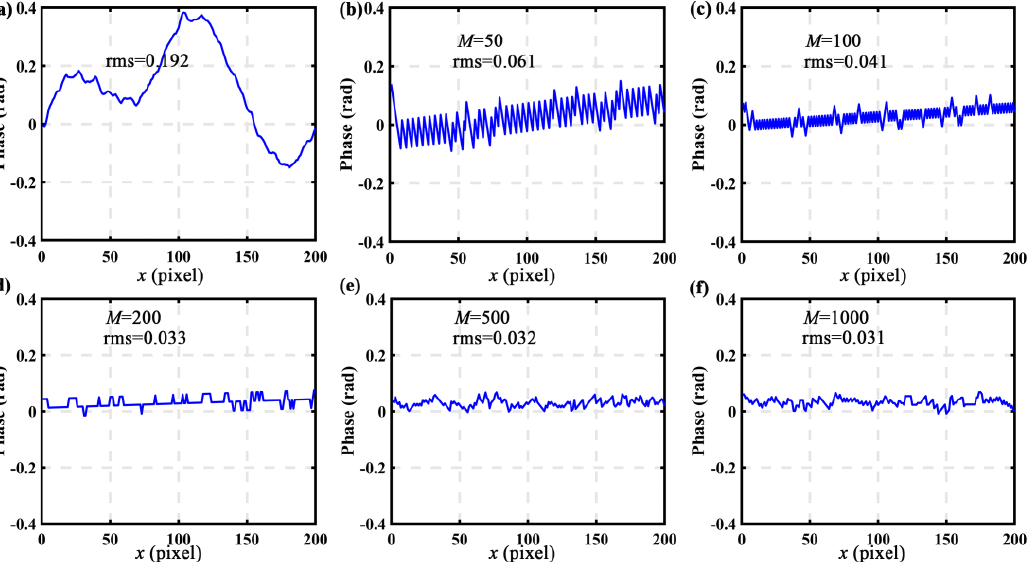
Figure 7. Cross-sections of different phase errors within one fringe period: ( a ) nonlinear errors before PPD adjustment and residual errors after PPD adjustment with ( b ) M = 50, ( c ) M = 100, ( d ) M = 200, ( e ) M = 500, and ( f ) M = 1000.